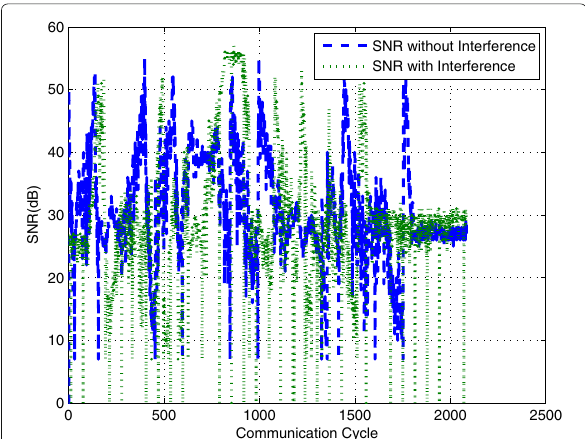
Fig. 4 SNR of the CBTC wireless link with/without interference from the PIS